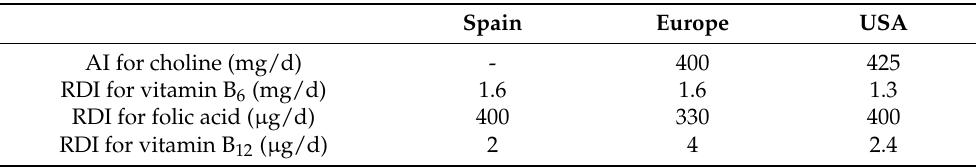
Table 2. Recommended dietary intakes (RDI) and adequate intake (AI) in women of childbearing age (18–45 years) for each micronutrient according to Spain (Moreiras et al. [1]), Europe (EFSA) [2] and USA (IOM)